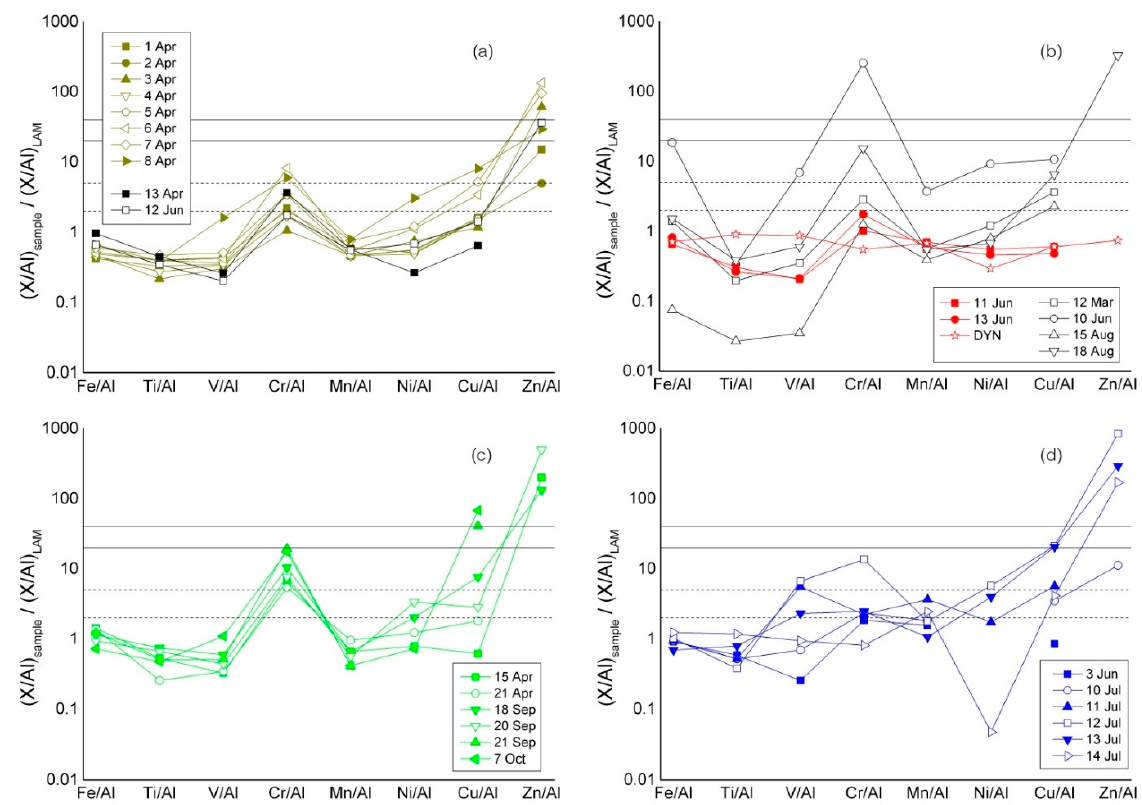
Figure 7. Enrichment factors (EFs) of the metals in the daily aerosol samples. The average composition of Dyngjusandur Icelandic sand (after [12]) is also reported for comparison. Values are normalized to average Lambahraun Icelandic sand composition (after [12]). Lines of the EFs equal to 2, 5 (both dashed lines), 10, and 20 (both solid lines), corresponding to moderate to significant metal enrichment of soils (after [39]), are reported for comparison.